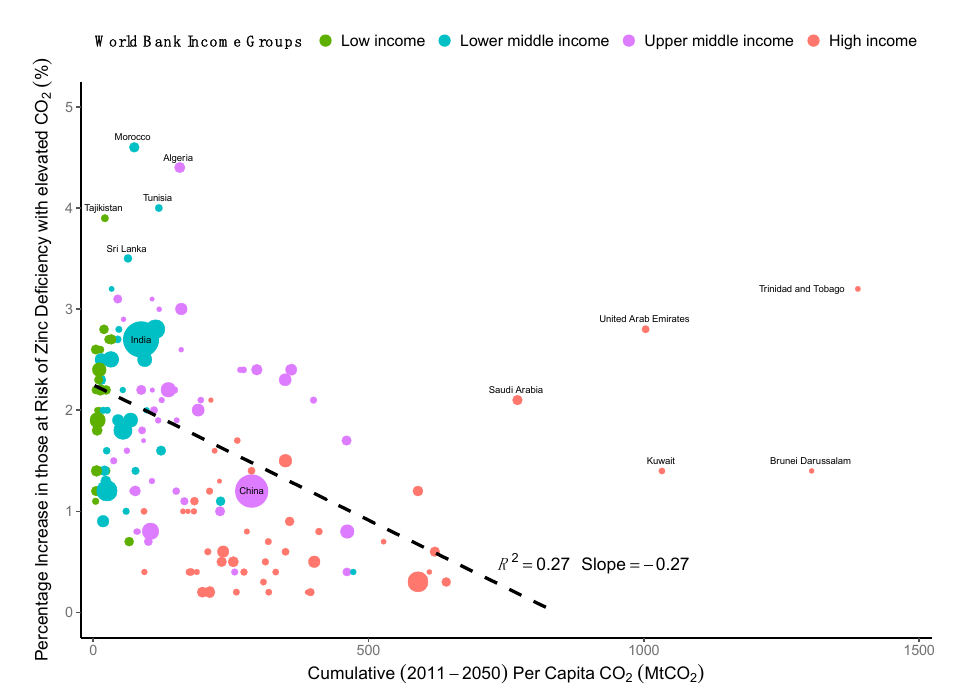
Figure 1. Population-weighted association between cumulative per capita CO 2 emissions and percentage increase in the population at risk of zinc deficiency with elevated CO 2 for 146 countries between 2011 and 2050 with select individual countries labeled. Bubble sizes depict the population prospect for each country in 2050 [19]. Note. CO 2 = Carbon dioxide; MtCO 2 = Metric tons of carbon dioxide.